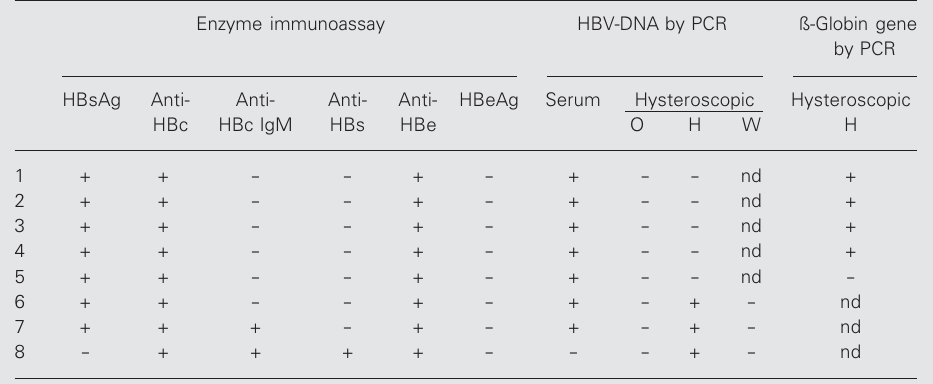
Table 2. Hepatitis B virus (HBV) serologic markers in serum and hysteroscopic HBV-DNA-positive samples. Enzyme immunoassay HBV-DNA by PCR ß-Globin